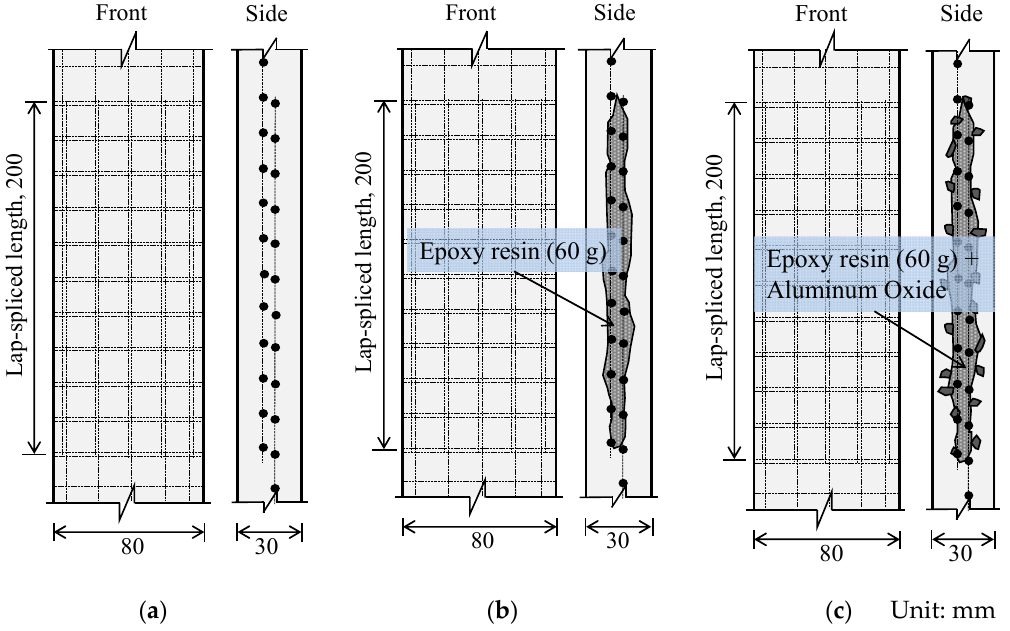
Figure 4. Illustrative details in the lap-spliced zone: ( a ) lap-spliced zone without surface treatment; ( b ) lap-spliced zone impregnated by epoxy; ( c ) lap-spliced zone coated with aluminum oxide after epoxy impregnation.